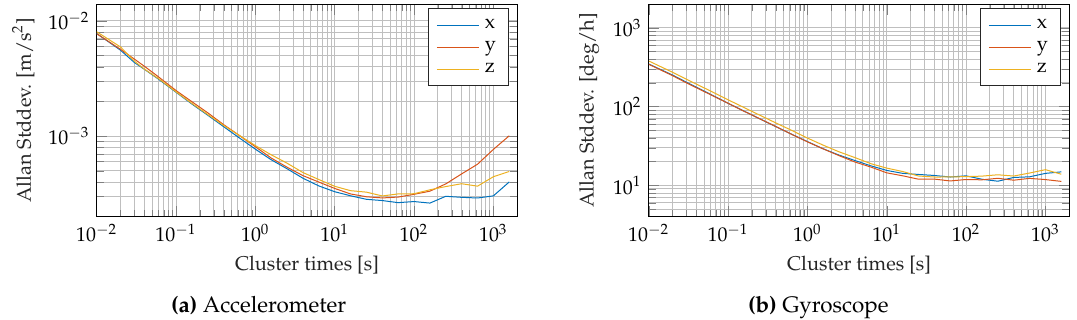
Figure 5. Allan variance curves for accelerometer and gyroscope of the Xsens MTi-700 used for estimation.